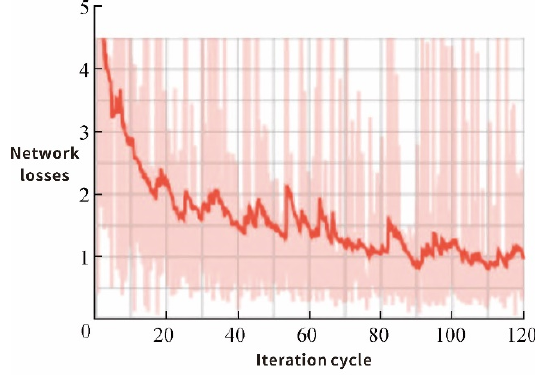
Figure 15. Training loss chart. Table 1. Network training loss and detection accuracy. Training Cycles